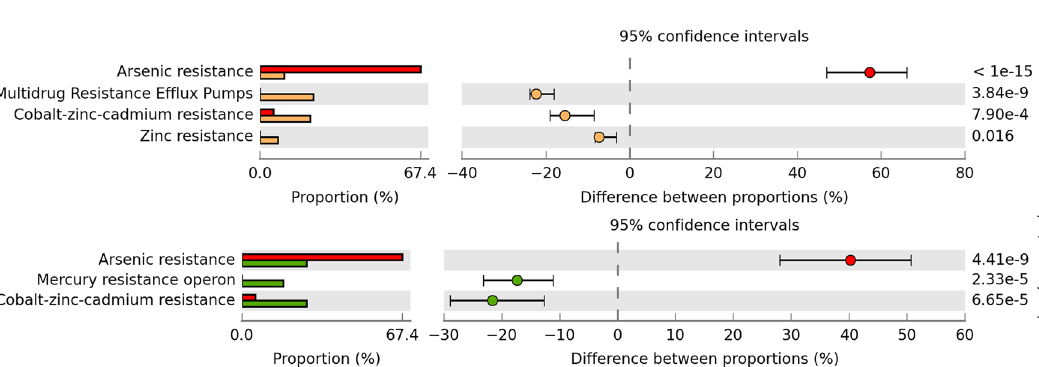
Figure 5. Predicted functional profiles derived from the Diamante Lake plasmidome (red bars), the Puquio de Campo Naranja plasmidome (orange bars) and the one derived from the wastewater treatment plant plasmidome in Visp, Switzerland (green bars). Percent “Resistance to antibiotics and toxic compounds” categorizable protein coding genes belonging to the “Virulence, Disease and Defense” SEED subsystem, and pairwise proportional differences calculated using STAMP. Fisher’s exact test was used and corrected P-values were calculated using Benjamini–Hochberg’s FDR. Only the statistically significant SEED subsystems are shown (q <